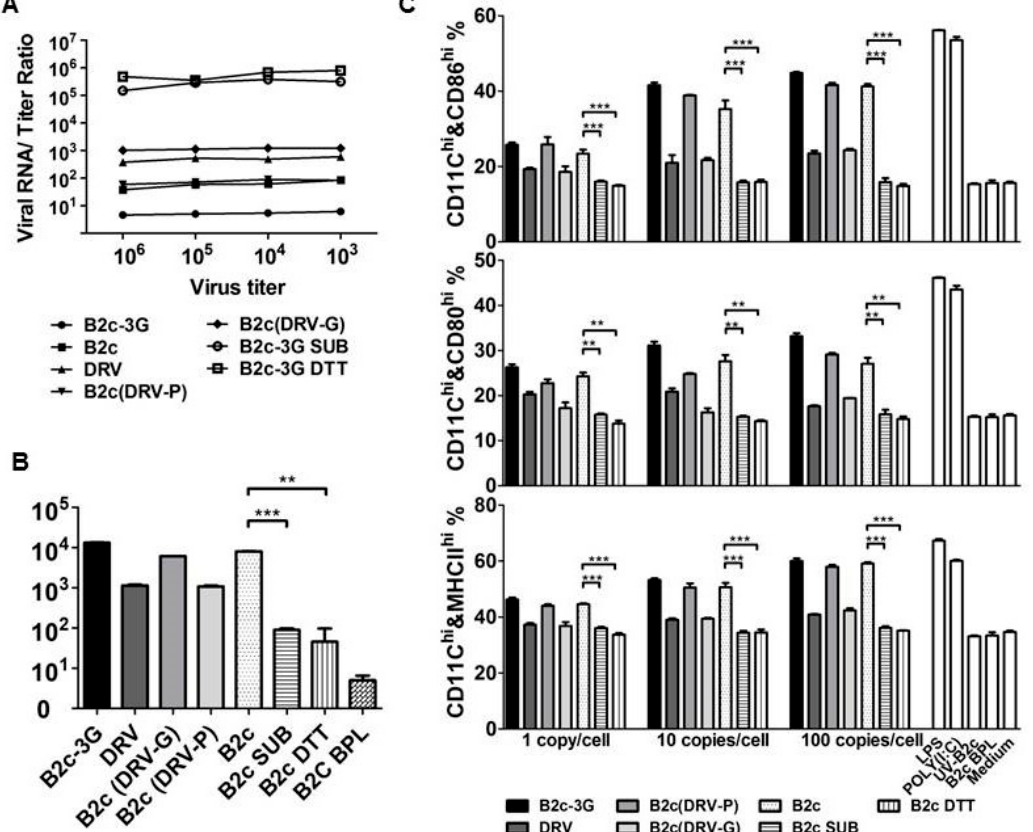
Figure 5. DC activation by different RABVs in vitro. ( A ) RABV genomic RNA/titer ratio of the indicated viruses detected by qRT-PCR and viral titration, respectively. ( B ) RABV-binding efficiency evaluated by qRT-PCR. ( C ) Flow cytometric analysis of the number of CD80-, CD86-, and MHC- positive DCs infected with CVS-B2c or DRV treated with 100 µ g of subtilisin protease or medium control buffer. Significance of differences between the percentage in normal and infected DCs were assessed by the unpaired t -test. *, p < 0.05; **, p < 0.01; ***, p < 0.001.